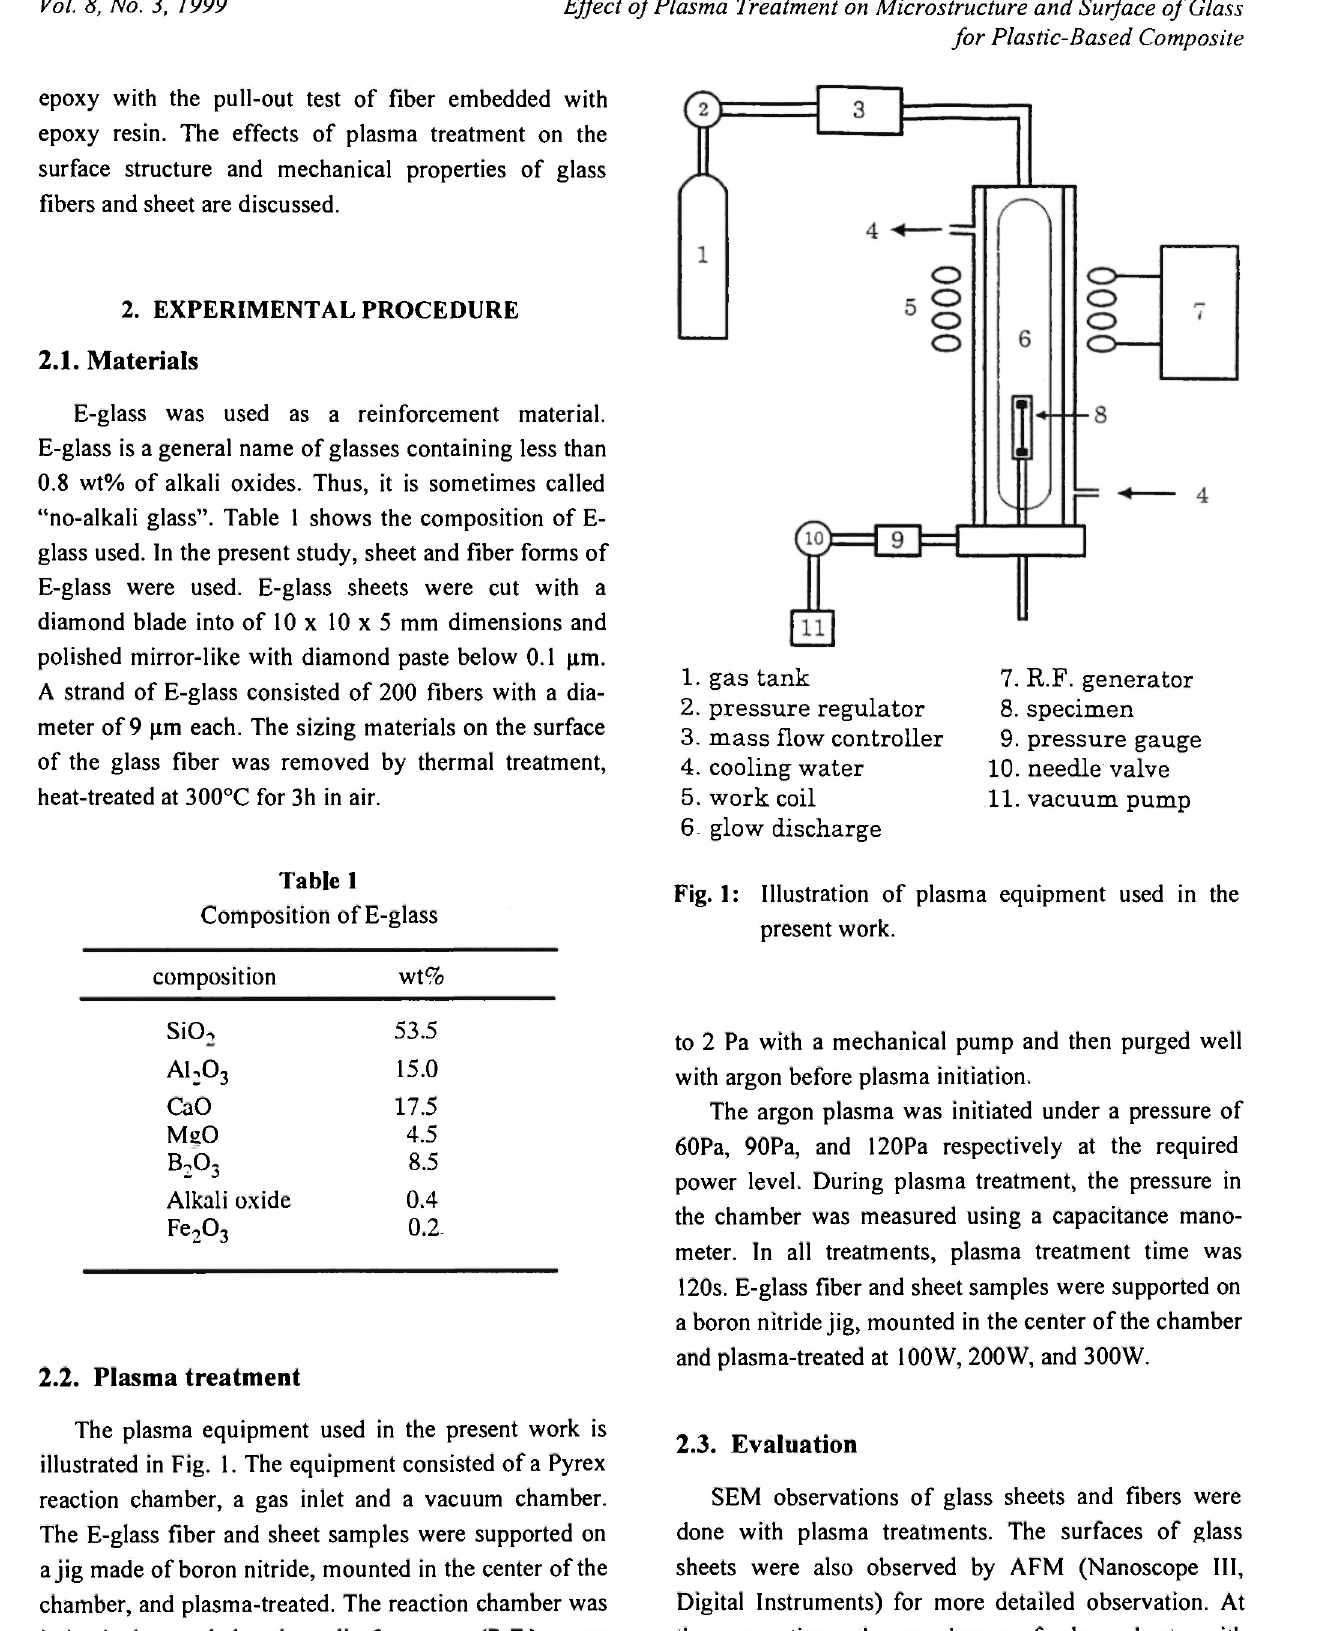
Fig. 1: Illustration of plasma equipment used in the present